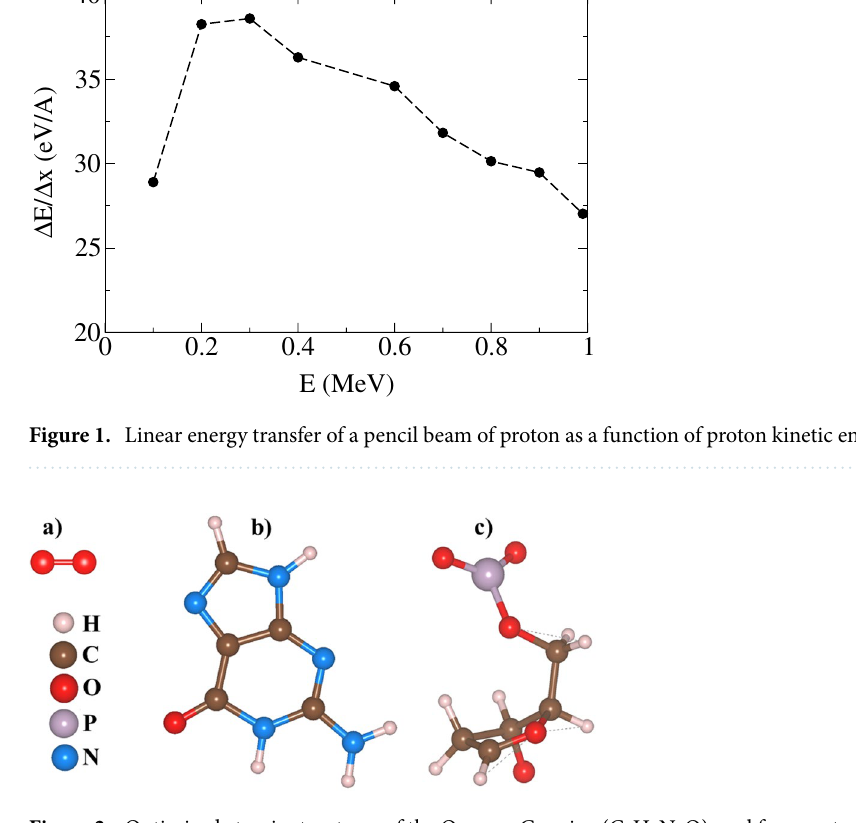
Figure 2. Optimized atomic structures of the Oxygen, Guanine (C 5 H 5 N 5 O), and fragment of Deoxyribonucleic acid (DNA). ( a ) Oxygen, ( b ) Guanine and ( c ) a fragment of